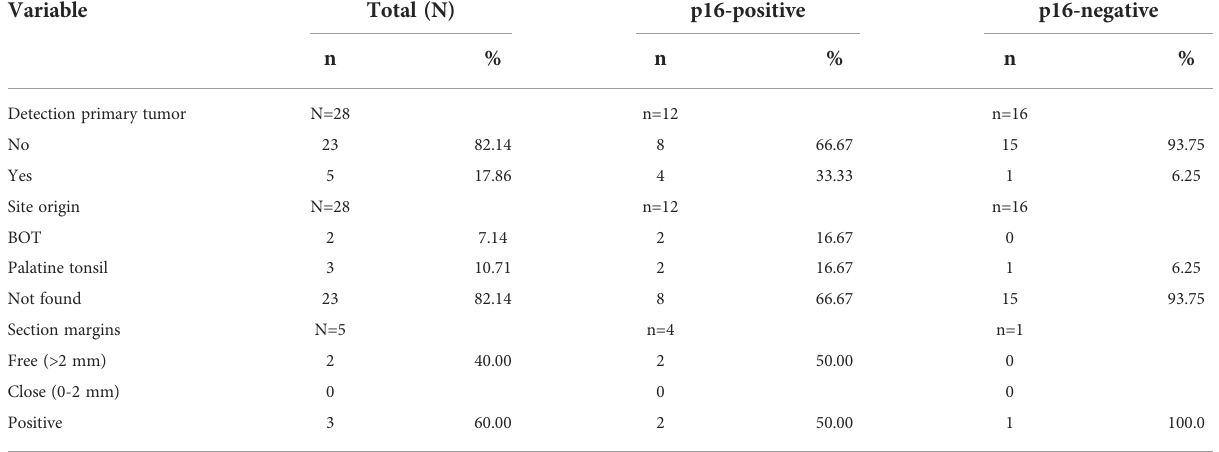
TABLE 6A TORS/TLM subgroup analysis: details on primary tumor detection according to p16 status. Variable